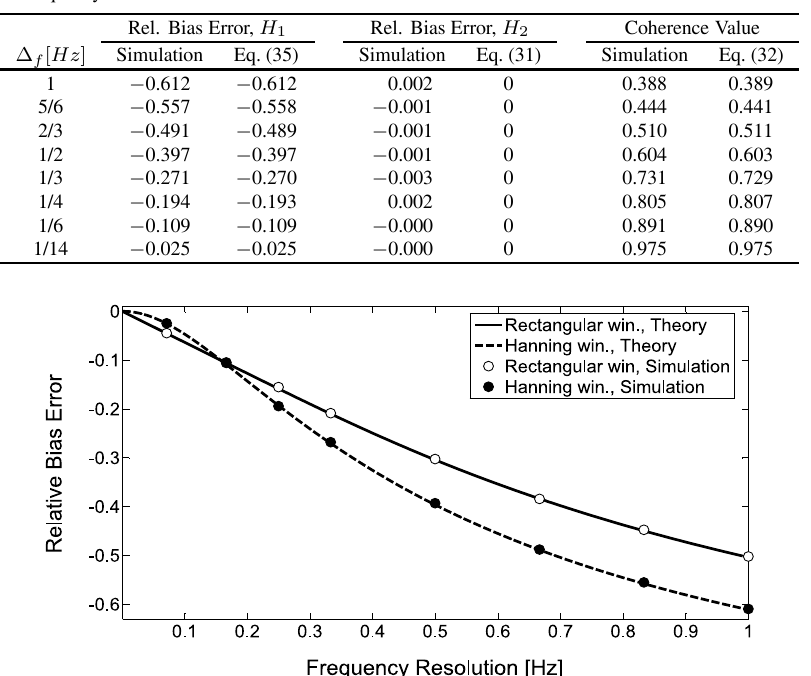
Table 1 The relative bias error at the resonance frequency obtained with the H 1 and H 2 -estimate and